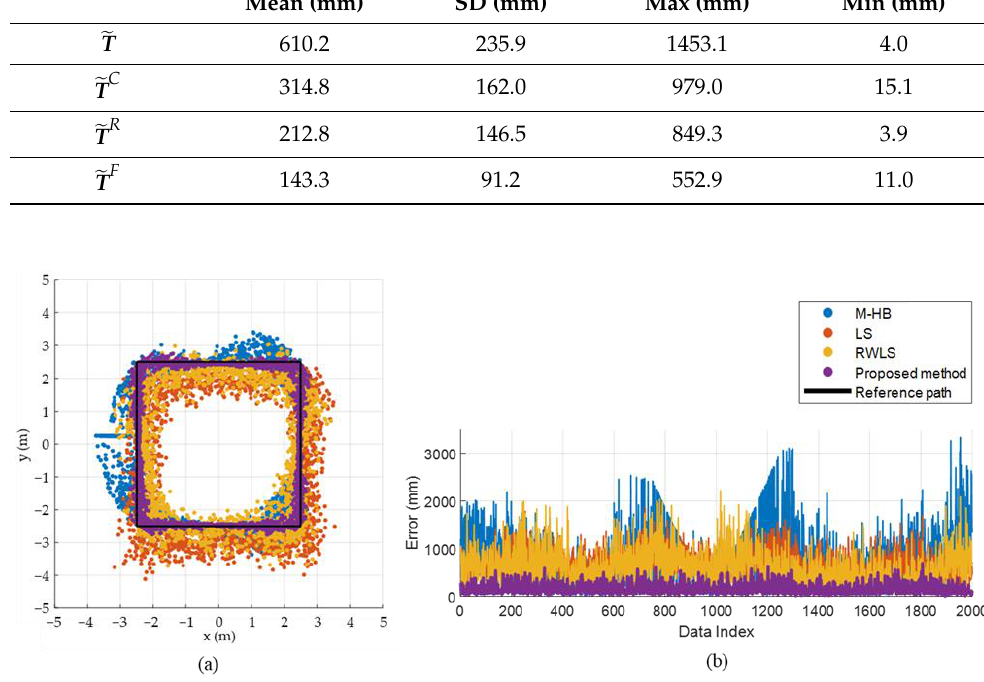
Figure 10. Comparison of estimation accuracy between the proposed method and previous methods for the square path: ( a ) comparison of estimation results, ( b ) comparison of estimation error.